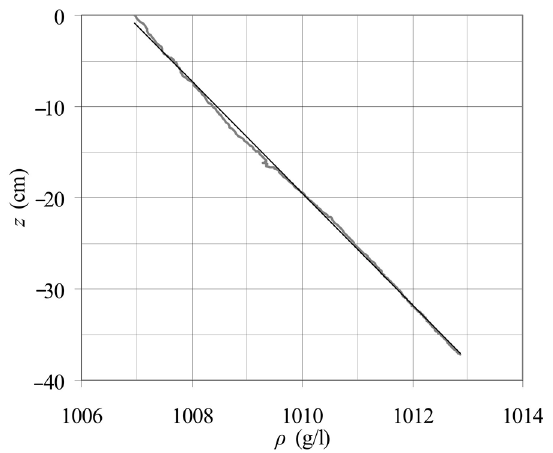
Figure 2. Density profile in the stratified tank up to 37.5 cm deeper than nozzle elevation (Exp-14). The thick line is the measured density, while the darker line is the least square linear approximation ρ ( z ) = 1006.8 + 0.163 z ( z in